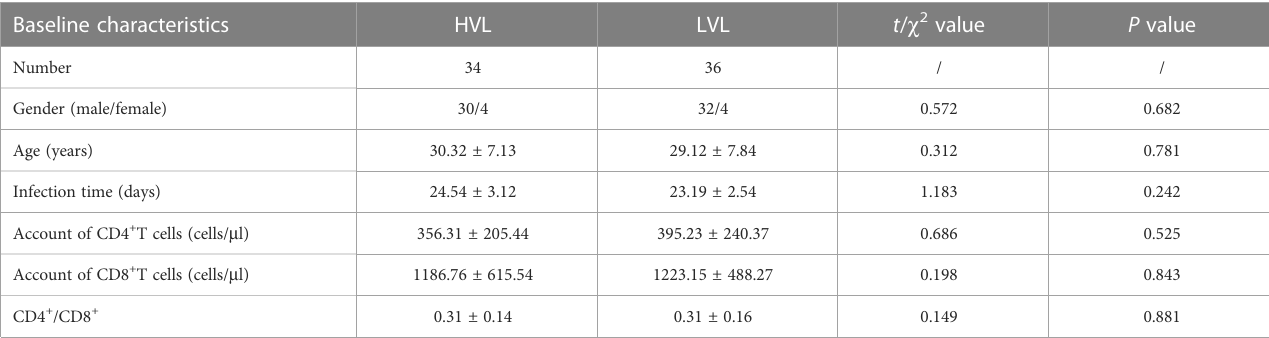
TABLE 1 Comparison of Baseline Characteristics Between the HVL and LVL Groups. Baseline